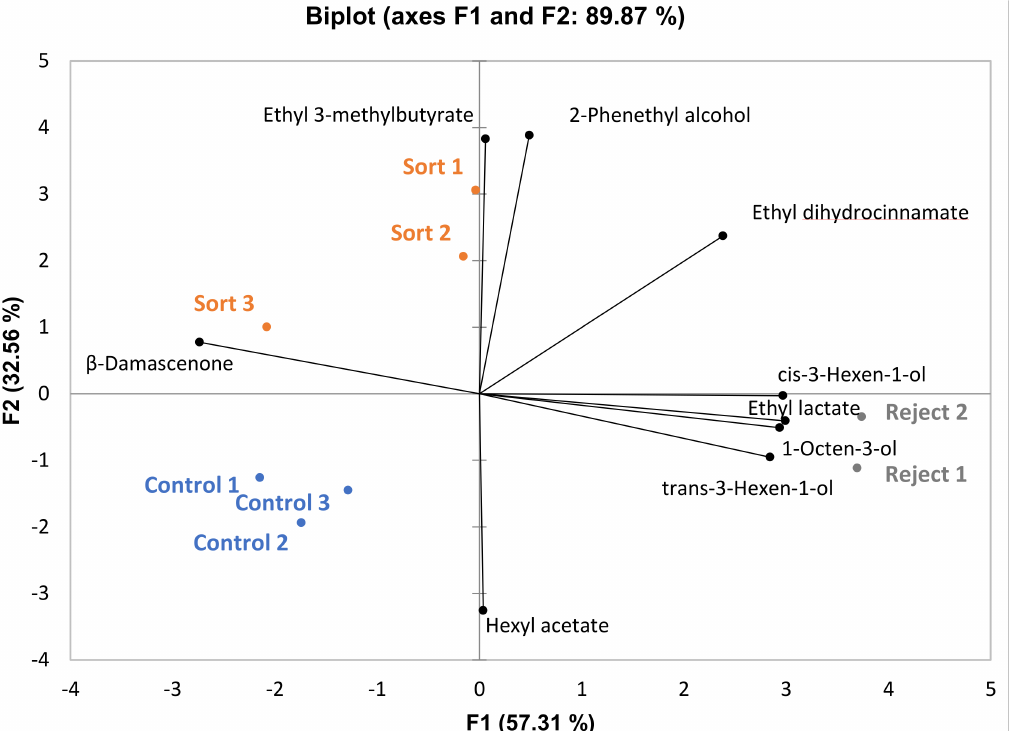
Figure 2. PCA biplot of volatile compounds that differed significantly among treatments for the Barbera wines ( p < 0.05, n = 3 for sort and control treatments, n = 2 for reject